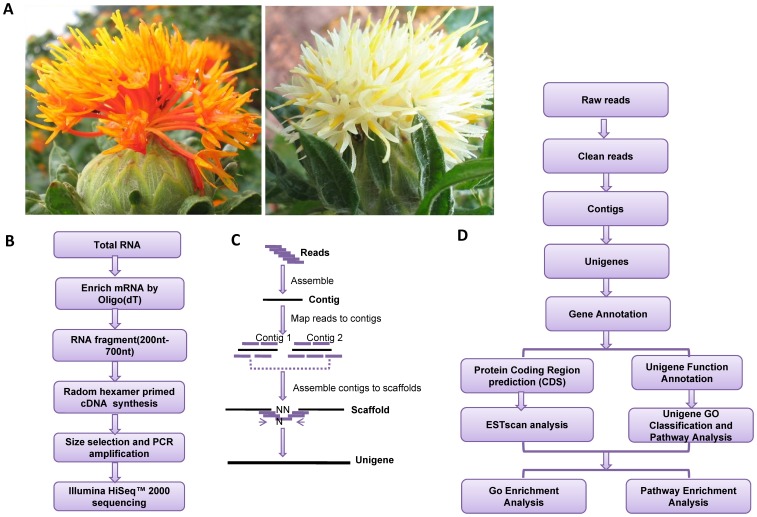
Safflower flower phenotypes and schematics of the transcriptome sequencing analysis.(A) Phenotypes of the red/orange (left) and white (mutant; right) flowers of Carthamus tinctorius L. used in this study. (B) Overall workflow of the experiment. (C) Overall workflow of the data assembly. (D) Overall workflow of the bioinformatic analysis.